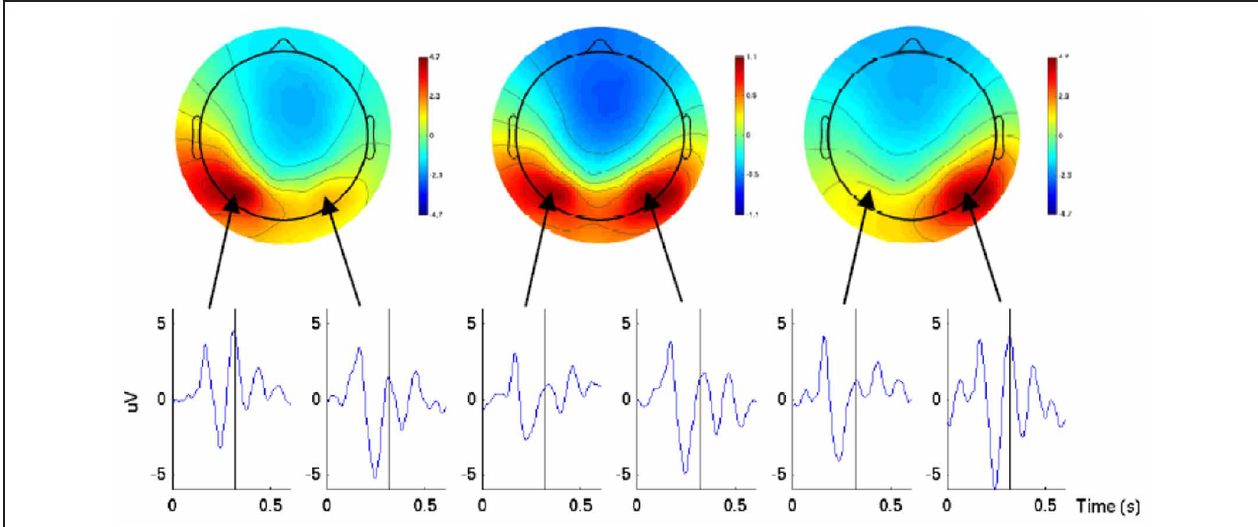
FIGURE 1 | Scalp maps and ERP waveforms of the back-projected parietal ICs for one subject in three conditions (left, center, and right) 320ms after the direction cue. The ERP